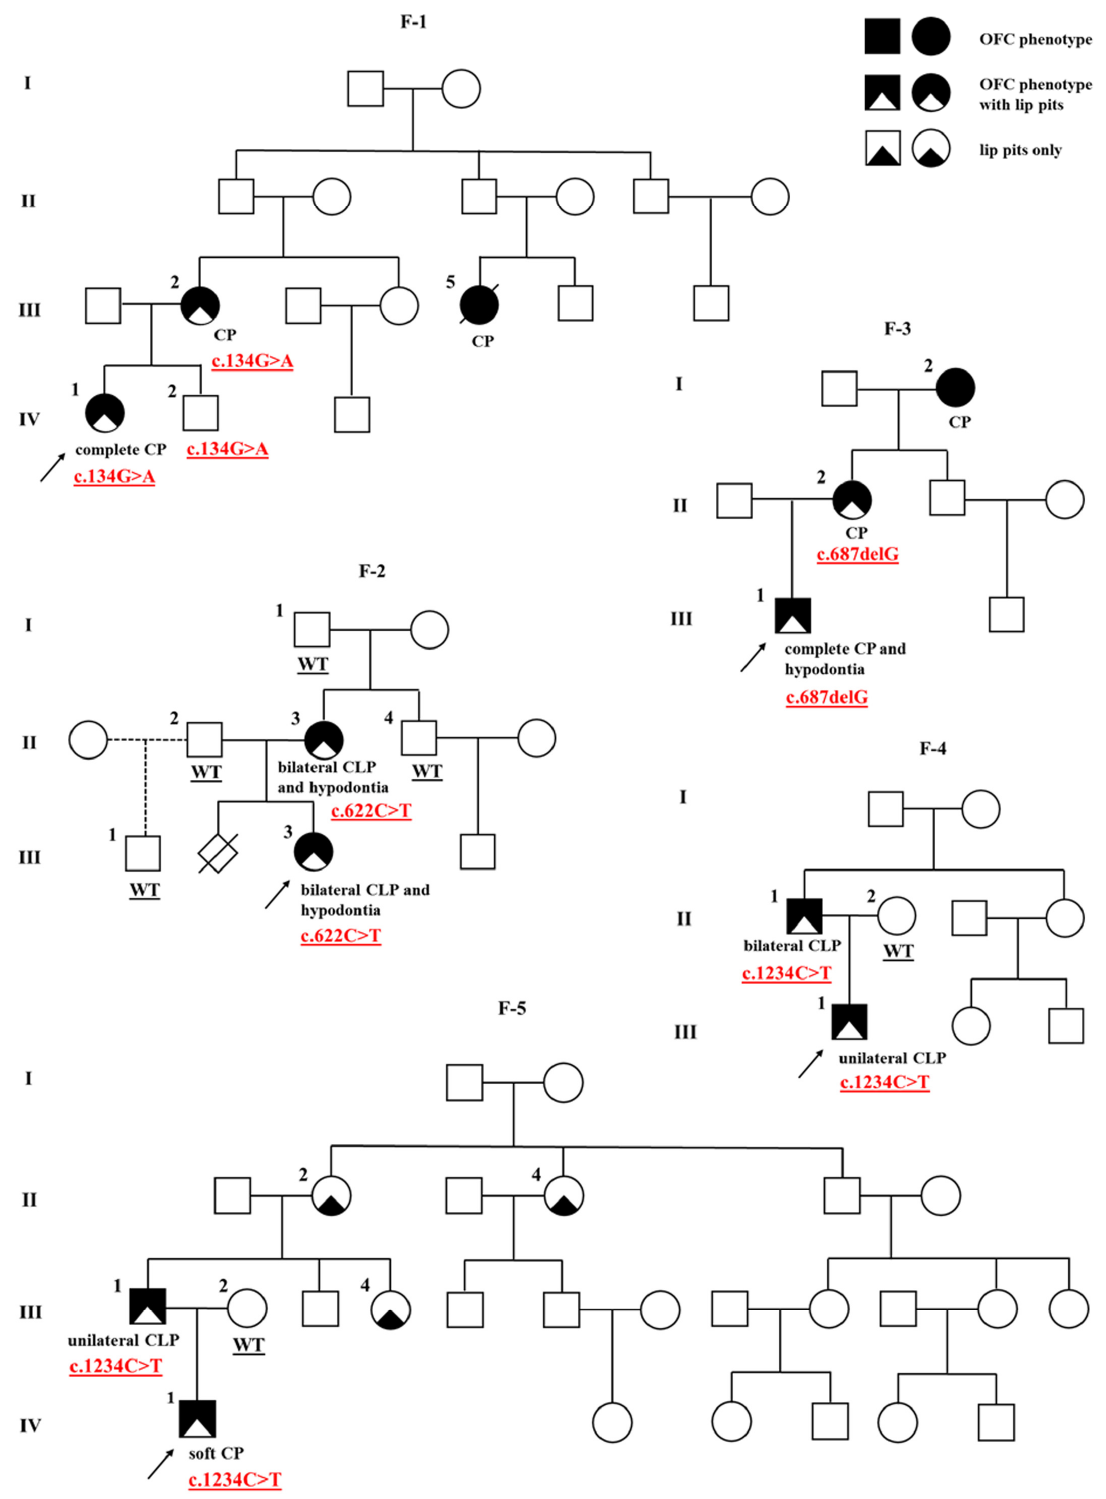
Figure 1. Pedigrees of the five Van der Woude syndrome families (F-1 to F-5) with IRF6 mutations. The proband is marked with an arrowhead. Genotype is given underneath each genetically tested individual. Roman numerals stand for the generations, while Arabic numerals stand for the individual members of the family. OFC, orofacial cleft; CLP, cleft lip, alveolus and palate; CP, cleft pal- ate.